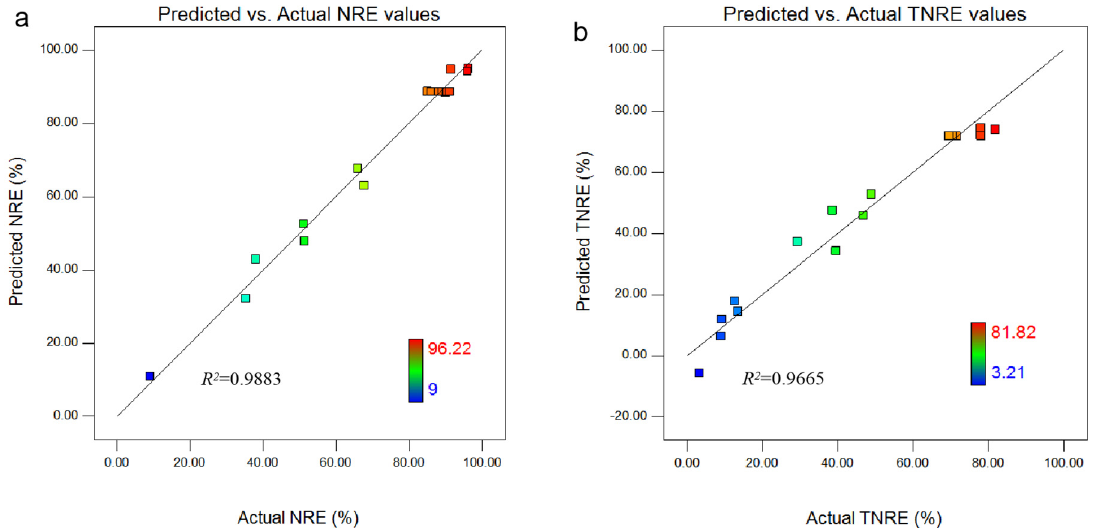
Figure 2. Stimulated versus experimental values of ( a ) NRE and ( b ) TNRE.